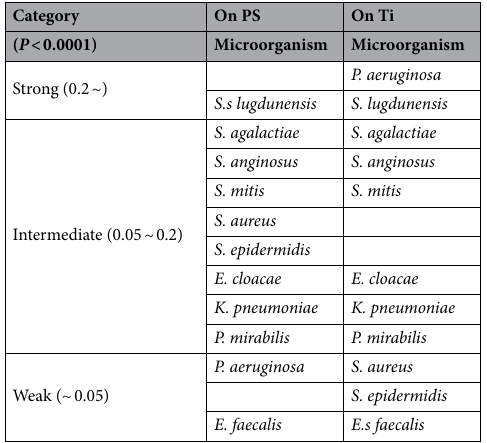
Table 1. Classification of each test microbe according to the degree of biofilm formation on PS and Ti. Microorganisms were classified on a subjective basis as strong, intermediate, or weak biofilm producers on PS if their absorbance values from CV stains were greater than 0.2, from 0.05 to 0.2, and less than 0.05, respectively. P-value < 0.0001 indicated statistical significance between groups (one-way